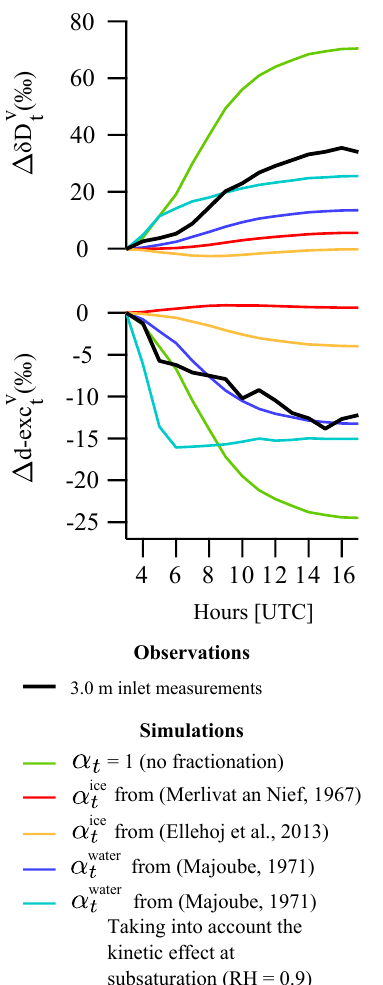
Figure 8. Measured and simulated (box model) deuterium and d- excess anomalies of the vapor during the warming phase. Kinetic effects occurring at subsaturation (RH = 0.9) have been calculated following Merlivat and Jouzel (1979) in a smooth